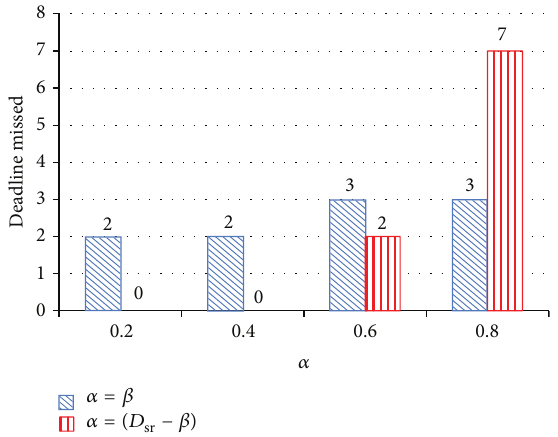
Figure 5: Performance comparison between original D 3 VFS and ED 3